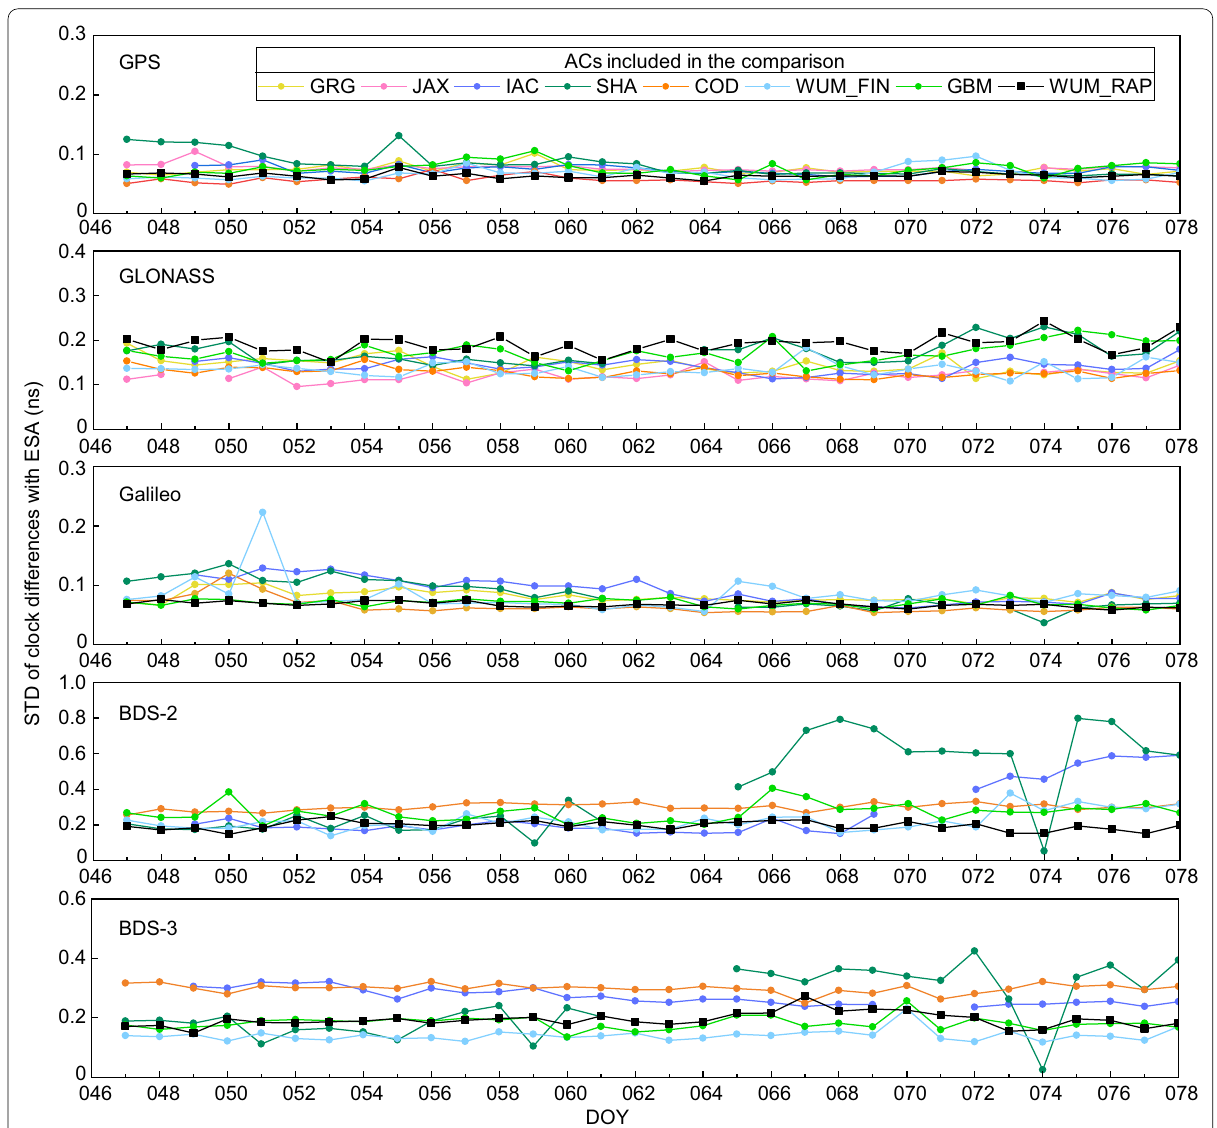
Fig. 3 STD series of differences between ESA clock products and those from other ACs. “WUM_RAP” in black represents the clock products provided in this